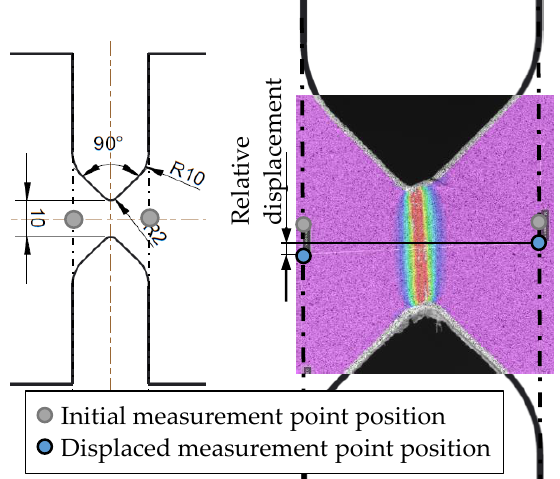
Figure 5. Measurement of the relative displacement in a shear test with digital image correlation (DIC).